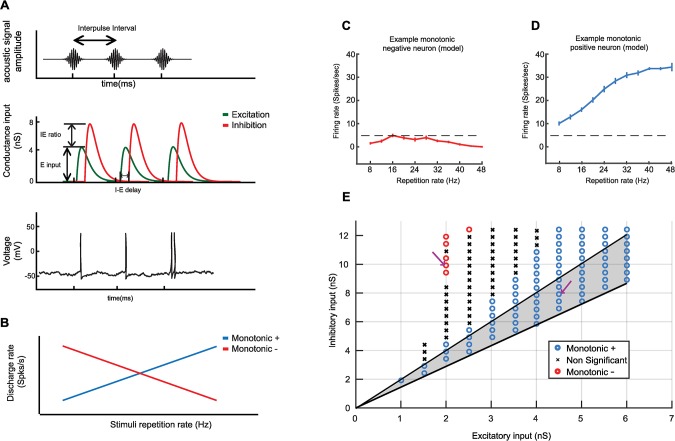
Computational model of an auditory cortical neuron.(A.) Simulated neural responses to an acoustic click train (top). each click was converted to an excitatory and inhibitory conductance input in our computational model, using an alpha function with a time constant of 5 ms (middle). Three parameters could be altered (I-E delay, E input and I/E ratio). Spikes were generated when membrane voltage reached a threshold (bottom). (B.) Cartoon of monotonic positive and negative responses. Monotonic positive neural responses increase the average discharge rate for stimuli with higher repetition rate. Monotonic negative responses decrease average discharge rate for stimuli with higher repetition rate. (C-E.) Examples of simulated neurons. Average discharge rate for increasing stimuli repetition rate for two example neurons. Model parameters for both neurons are the following: Neuron example 1 (C.): Excitatory input = 2 nS, Inhibitory input = 10 nS. Neuron example 2 (D.): Excitatory input = 4.5 nS, Inhibitory input = 8.5 nS. Error bars indicate s.e.m. (E) classification of neuron type across two parameters (Excitatory input and Inhibitory input) with a fixed I-E delay of 5 ms. The arrows indicate the parameters used for the example neurons (left arrow for example 1, right arrow for example 2). Shaded area indicates biologically plausible values where the I/E ratio is between 1.4 and 2.0.